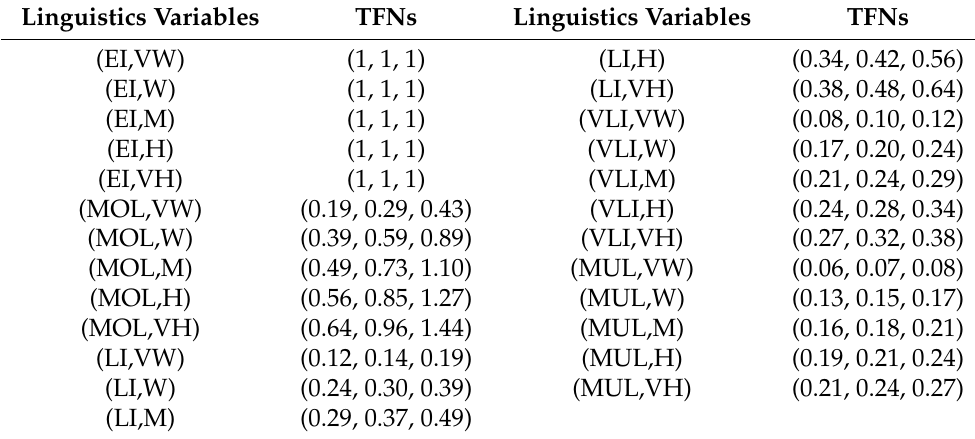
Table 5. For weighting criteria, transformation procedures for Z-number to TFN depending on linguistic characteristics are